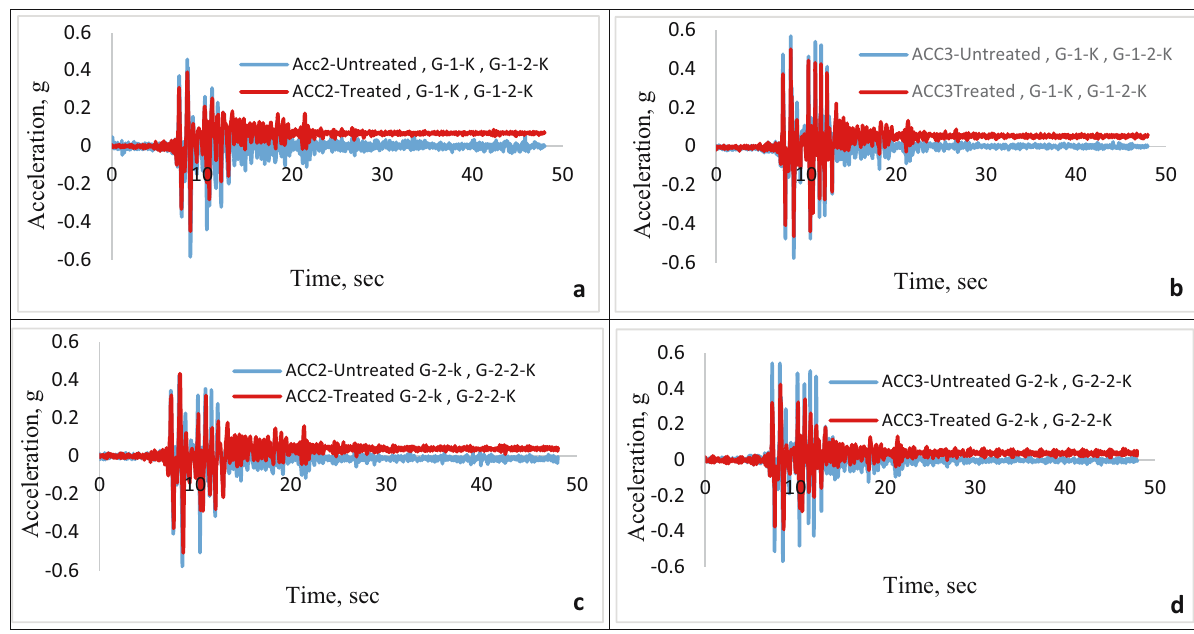
Figure 10: Acceleration within di ff erent depths of treated and untreated soil with nano - clay: ( a and b ) ACC2 and ACC3 at 50% axial load and 50% axial load and 100% lateral load; ( c and d ) ACC2 and ACC3 at 100% axial load and 100% axial load and 100% lateral